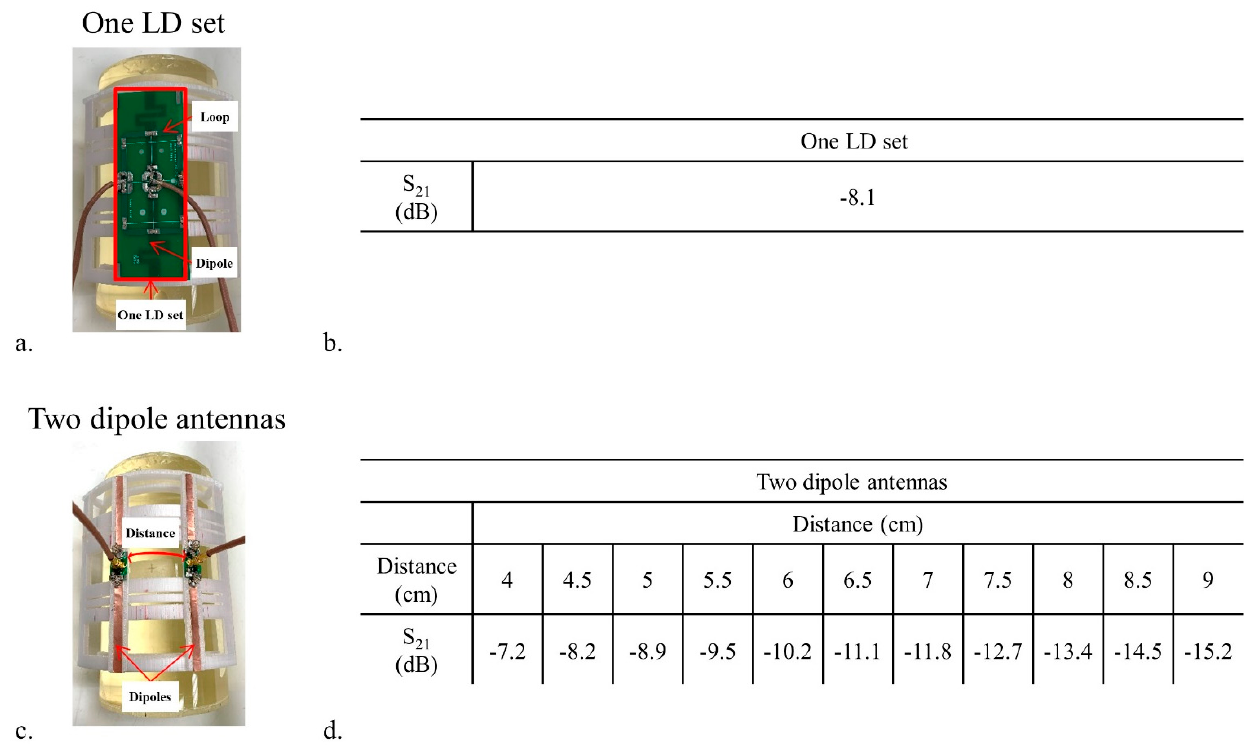
Figure 2. Photographs of an LD set ( a ) and two dipole antennas ( c ) on the phantom. S 21 values between the loop and the dipole antenna in the LD set ( b ) and two dipole antennas ( d ) were measured through the circumferential center ‐ to ‐ center distance from 4 cm to 9 cm.